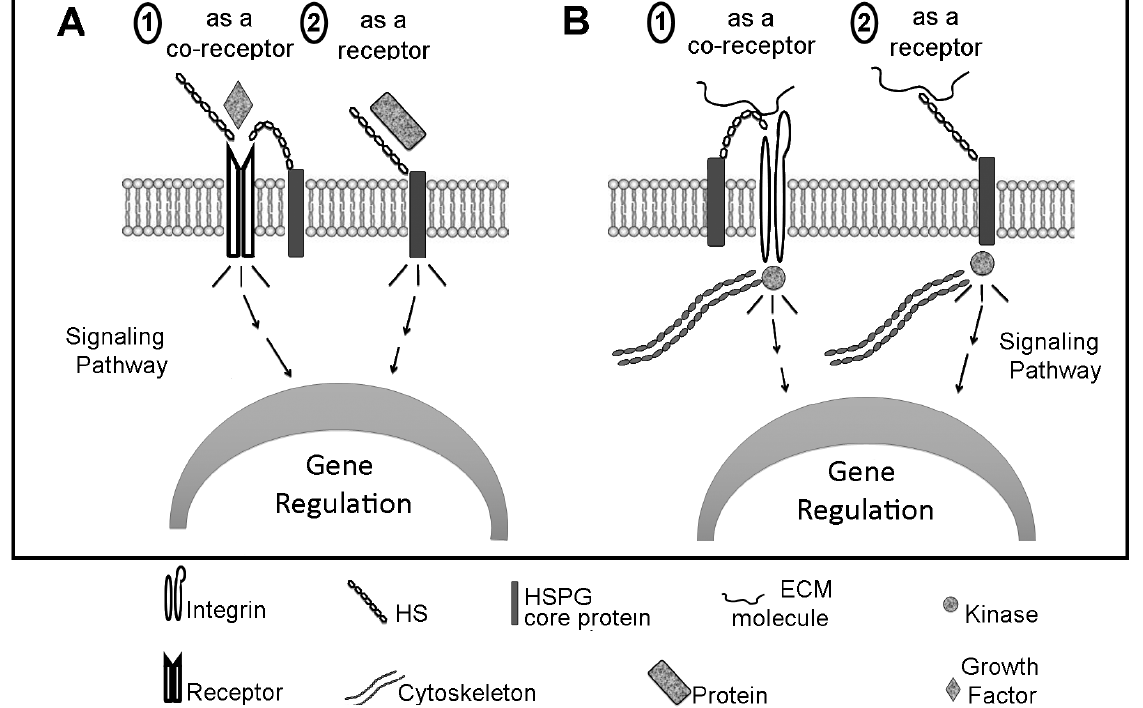
Fig. 3 – Heparan sufate proteoglycans features in cell signaling. HSPG can trigger cell response through signal transduction pathways as a receptor or co-receptor in a cytoskeleton independent (A) or dependent manner